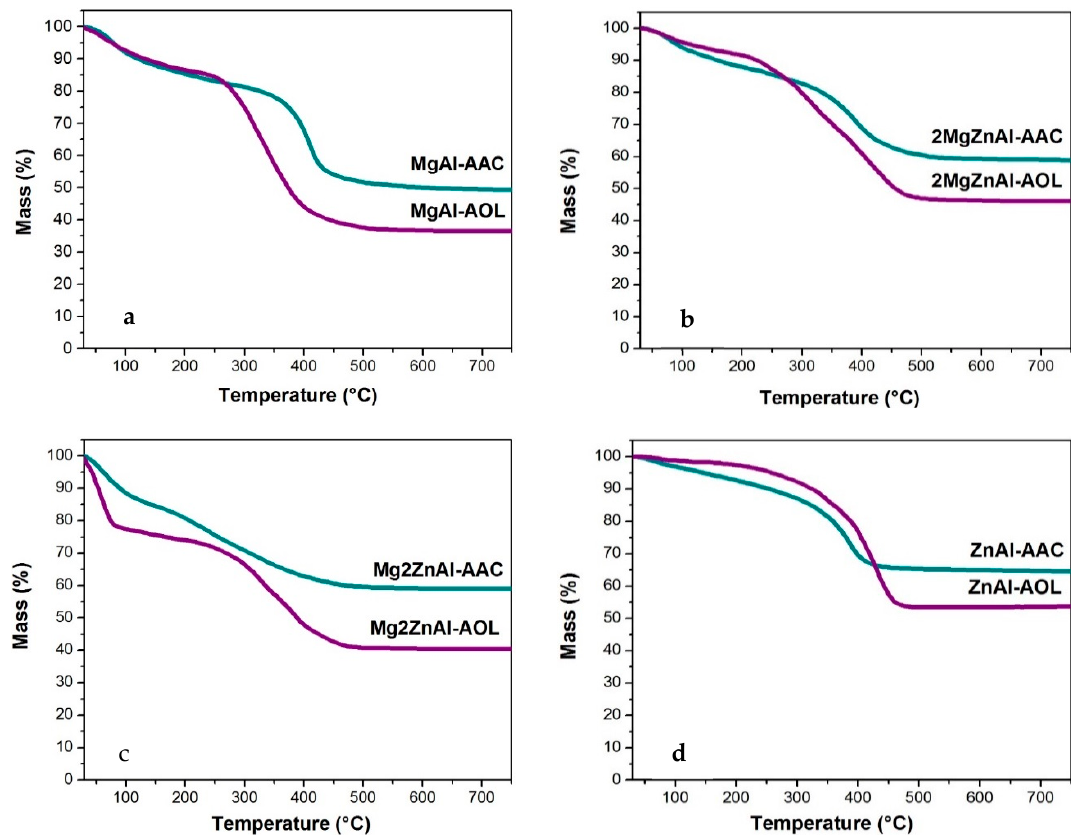
Figure 8. Thermogravimetric analysis for modified materials with acrylate anion (AAC) and oleate anion (AOL) for: ( a ) MgAl, ( b ) 2MgZnAl, ( c ) Mg2ZnAl, and ( d ) ZnAl.